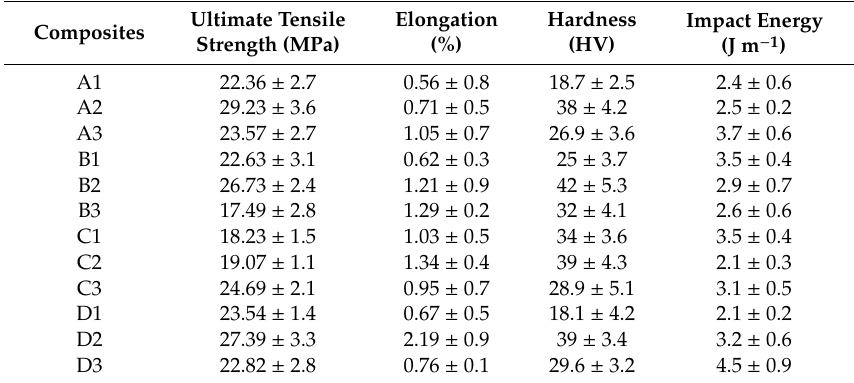
Table 4. Mechanical properties of the bagasse composites.